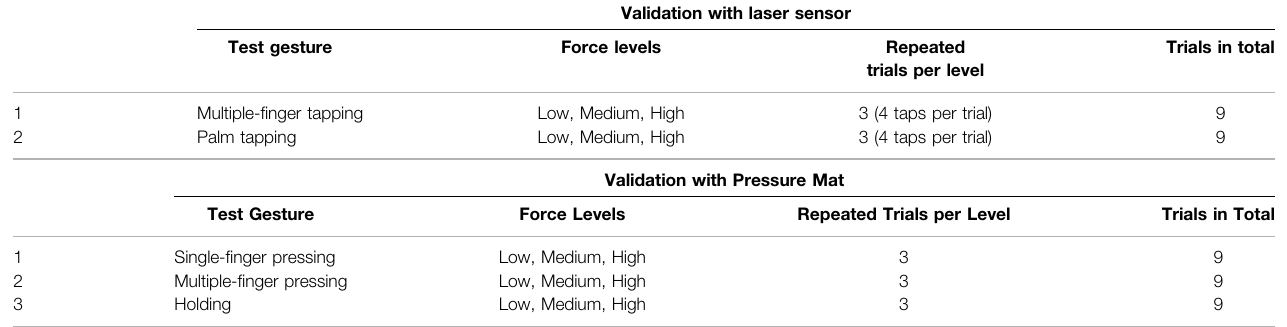
TABLE 4 | Experiment procedure for validating indentation